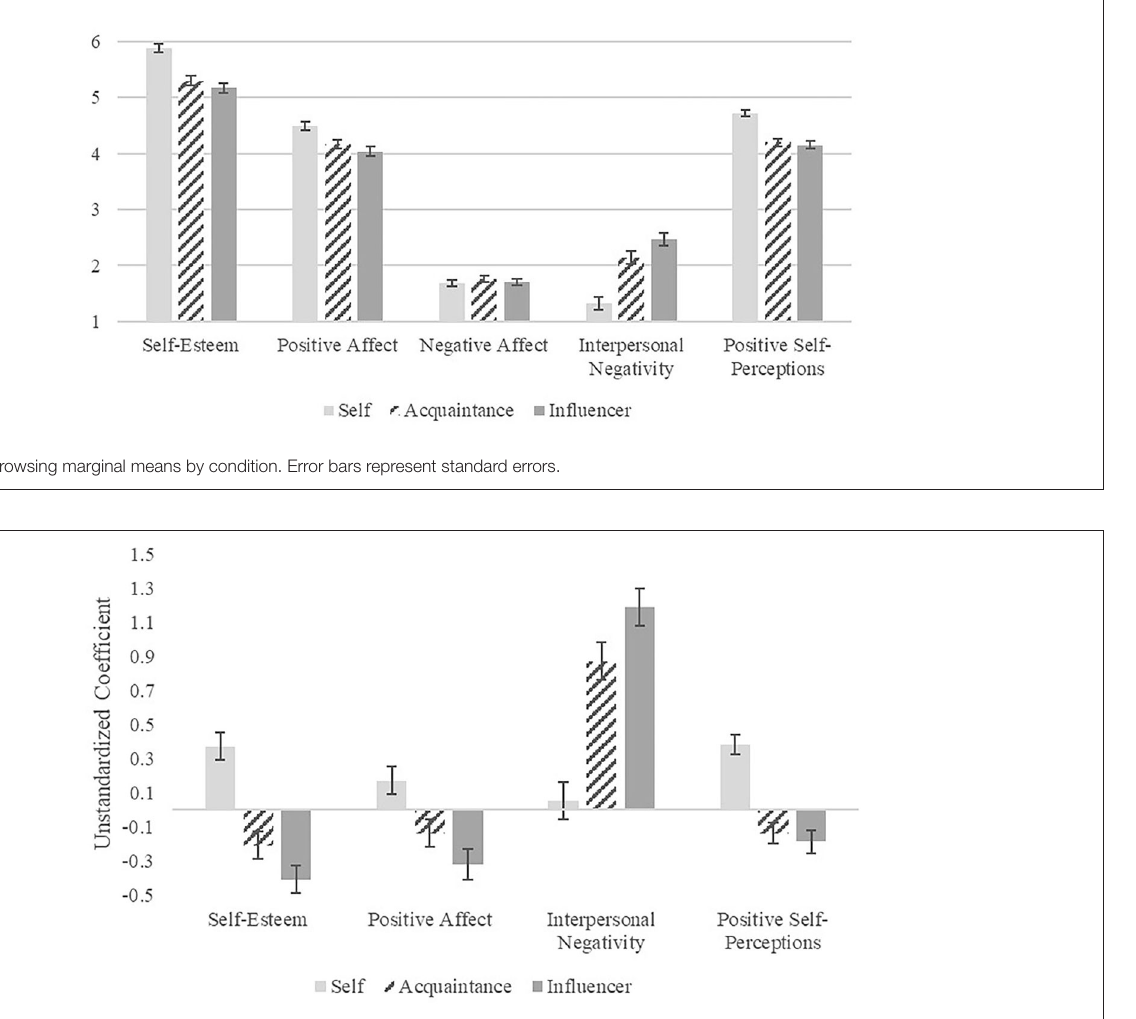
FIGURE 2 | Within-person changes in affect and self-perceptions by condition. Error bars represent standard errors.